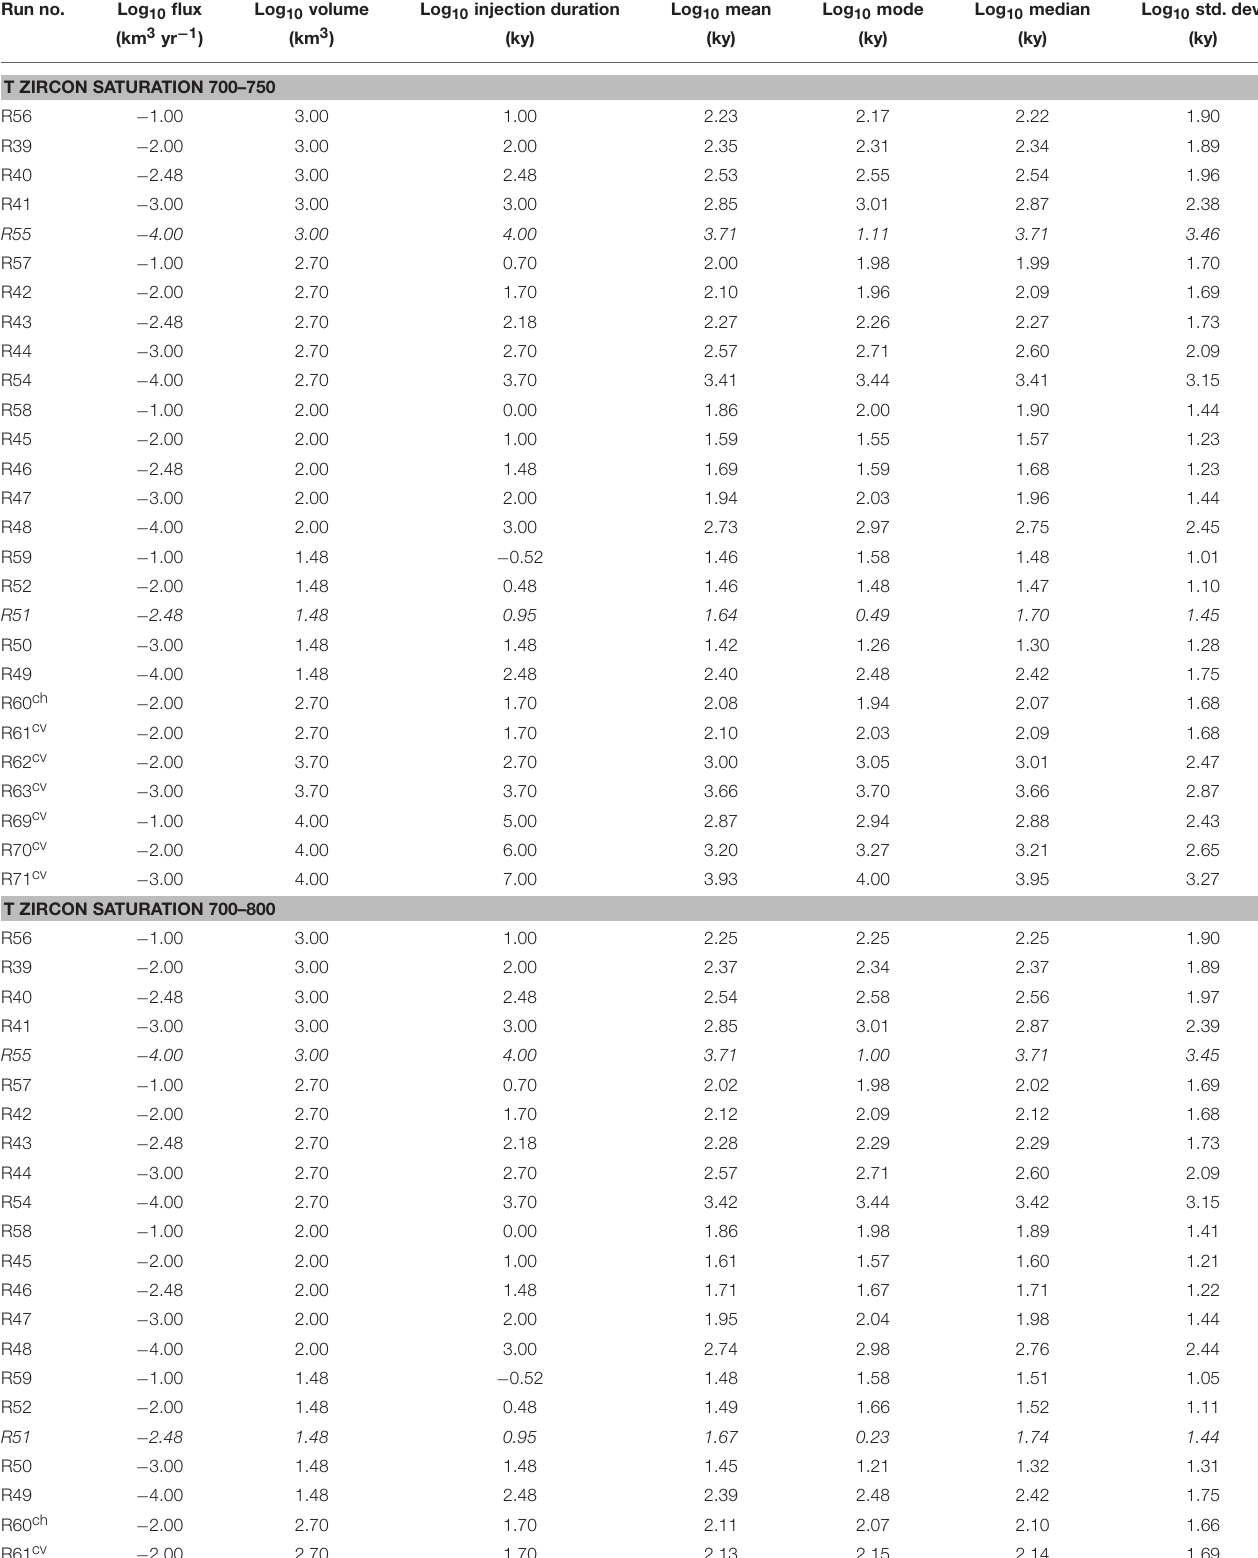
TABLE 1 | Statistical parameters obtained for the different injected volumes, injection fluxes, and ranges of zircon saturation temperature. Run